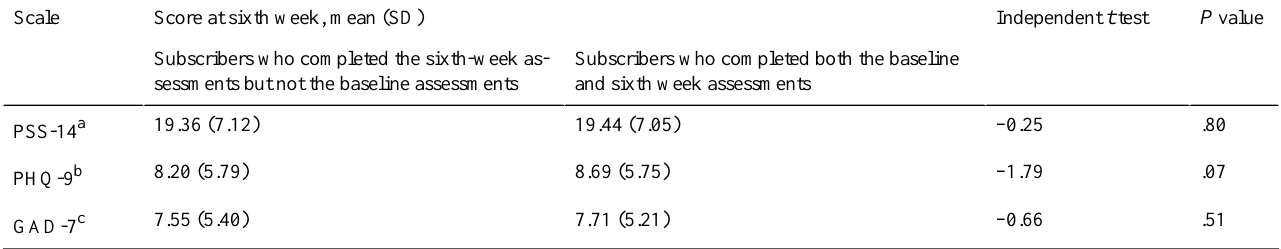
Table 7. Comparison of the mean scores on the PSS-10, GAD-7, and PHQ-9 between subscribers who completed both the baseline and 6-week surveys and subscribers who only completed the 6-week